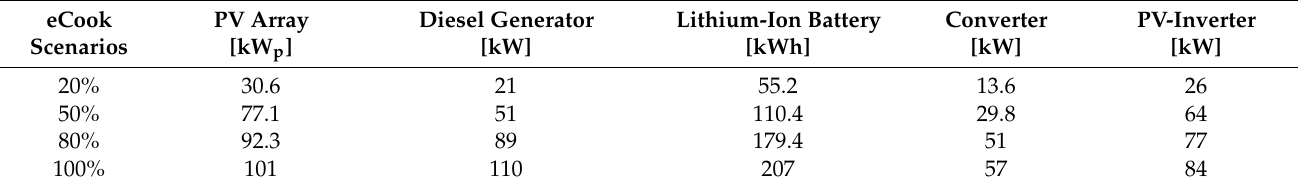
Table 6. Component sizes for eCook mini-grid deployment scenarios (when considering 1.2 DC/AC ratio). eCook